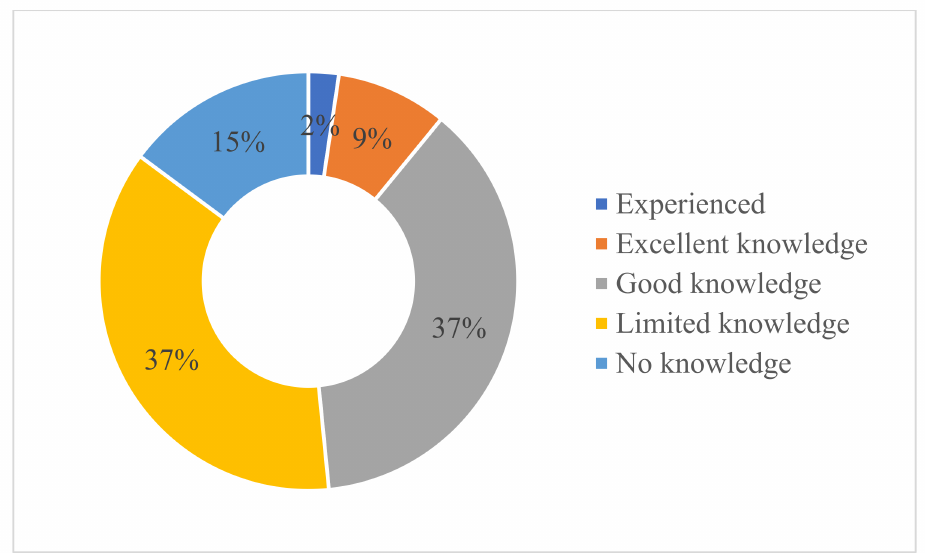
Figure 4. Knowledge of implementing various policy instruments for climate change adaptation in mopane